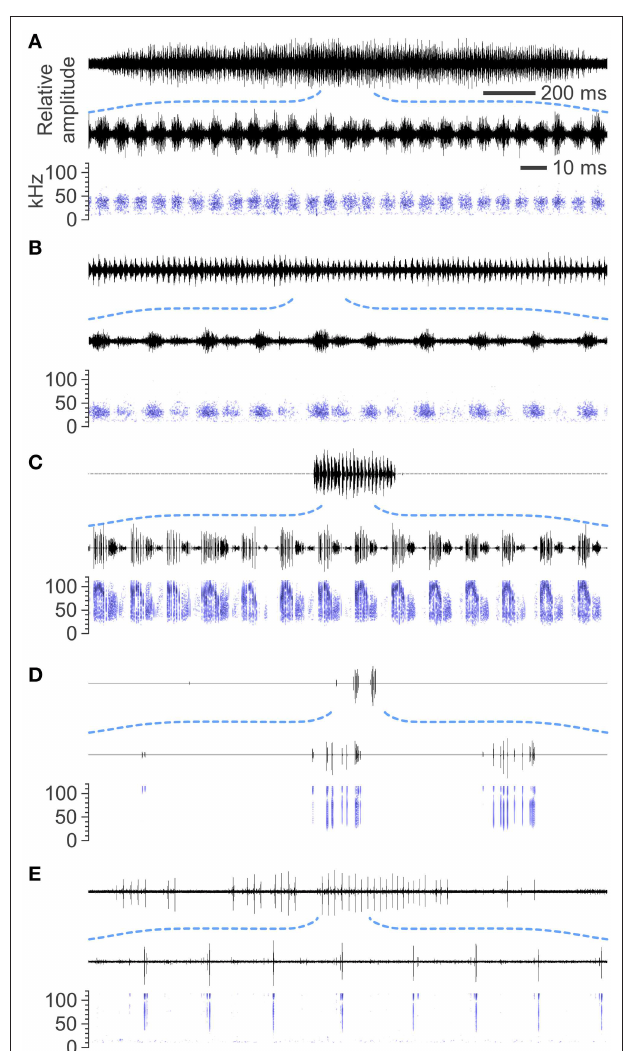
FIGURE 1 | Examples of male courtship songs in crambid moths. Representative oscillograms and spectrograms are shown. (A) Ostrinia palustralis , (B) Ostrinia zealis , (C) Desmia funeralis , (D) Palpita nigropunctalis , and (E) Glyphodes pyloalis .